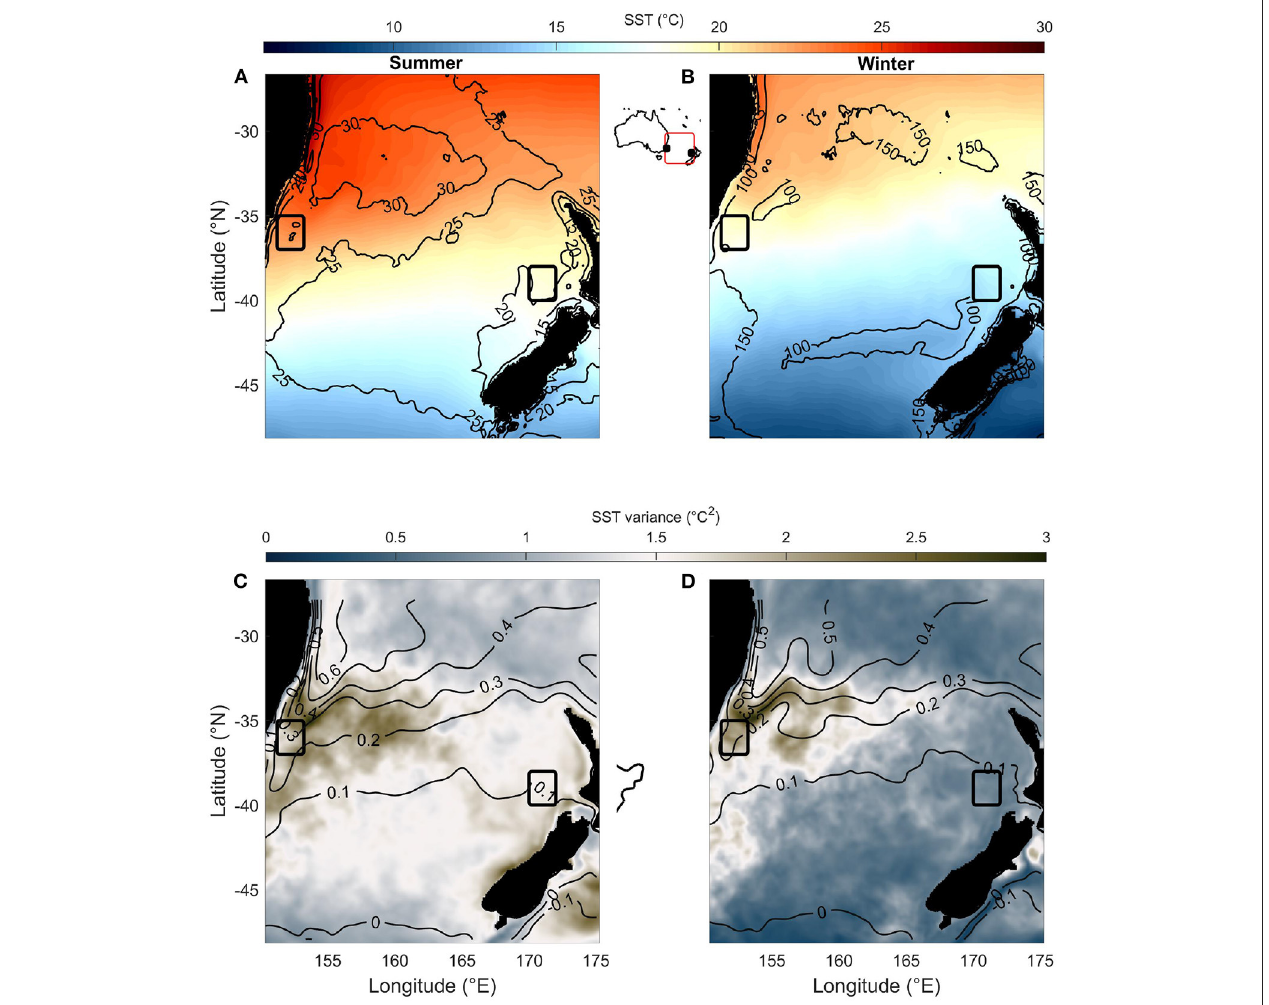
FIGURE 1 | Mean sea surface temperature (SST) from the Bluelink OFAM3 model during the summer months (A,C) and winter months (B,D) SST [colorbar, (A,B) ] with MLD contours (m). Panels (C,D) ) show the SST variance with SLA contours. Values are based on the mean of the 30-year study period (1985–2014). The two boxes analyzed in the study are marked with black rectangles, Eddy box is on the left and NZ box on the right. An orientation map shows the study boxes in